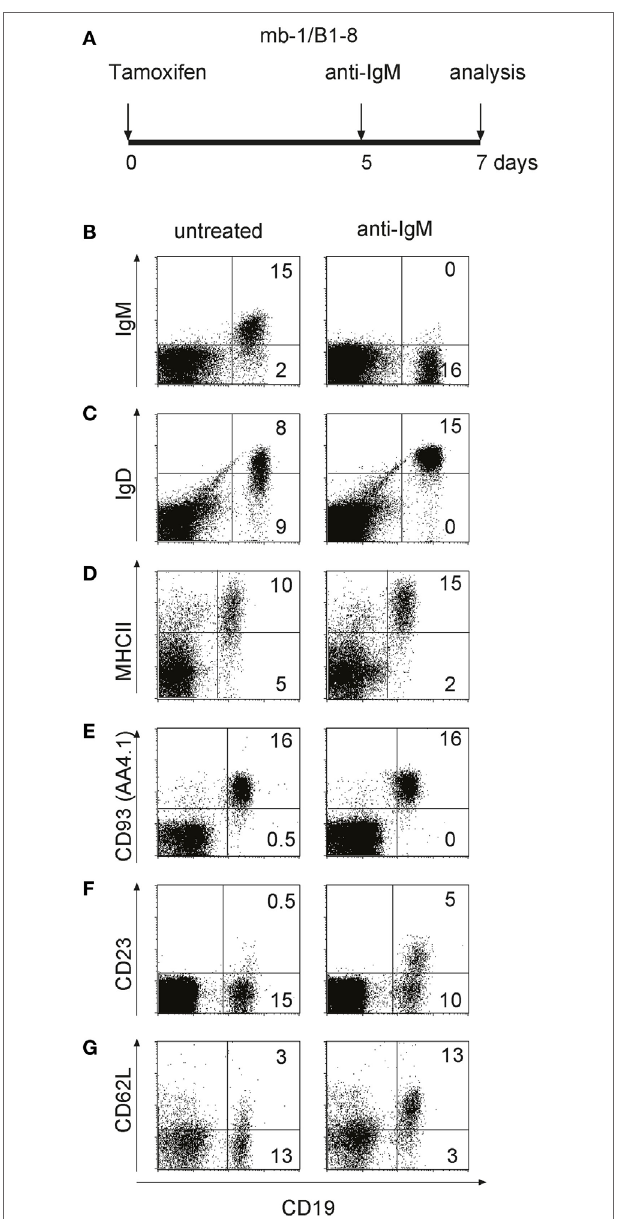
FigUre 4 | In vivo activation and maturation of anti-IgM treated transitional 1 (T1)-B cells. (a) Imb-1/B1-8 mice were treated with F(ab ′ ) 2 fragments of anti-mouse IgM at day 5 post induction (p.i.) and lymphocytes derived from the spleen were analyzed 2 days after treatment. (B–g) Splenic lymphocytes of untreated (left panel) and anti-IgM treated (right panel) imb-1/B1-8 mice at d7 p.i. were isolated and stained with antibodies against CD19 in combination with those against MHC class II, IgD, IgM, CD93 (AA4.1), CD23, or CD62L. Representative data from six independent experiments with two mice are